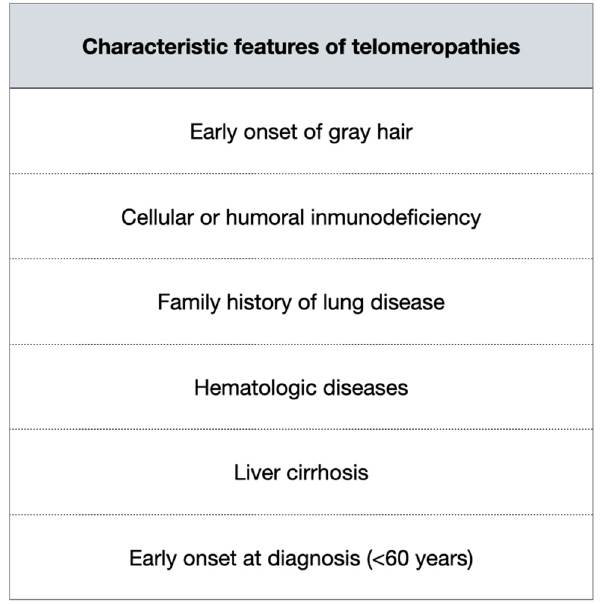
Figure 2. Characteristic features of